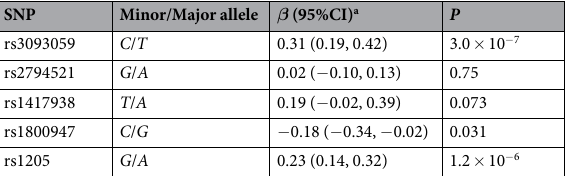
SNP Minor/Major allele β (95%CI) a P